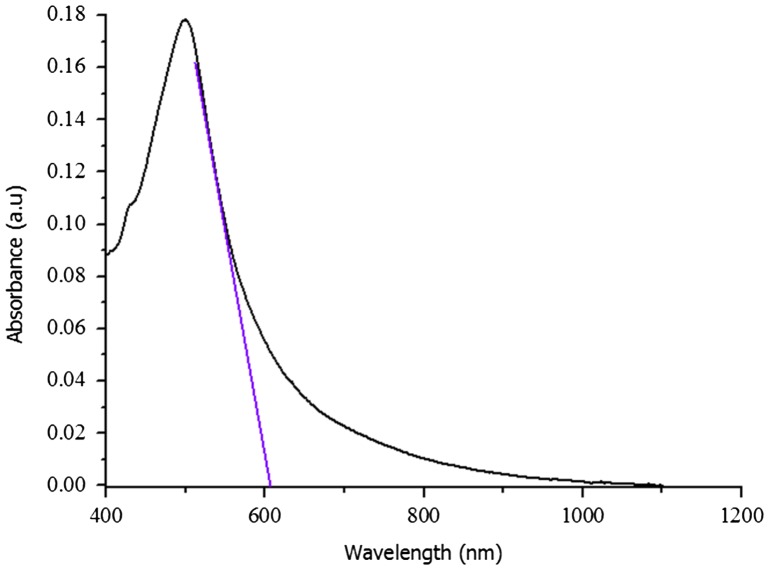
Band gap estimation of DBSA-doped PNVC–Ppy.